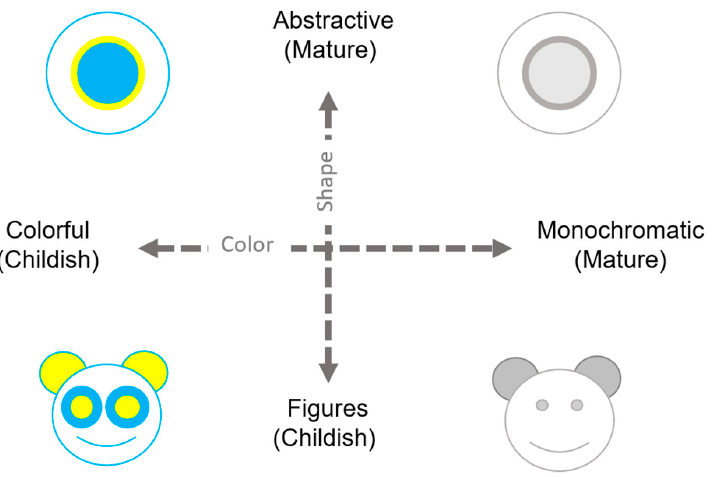
Figure 7. Abstract diagrams created to define guidelines for designing medical devices according to the desired user experience.